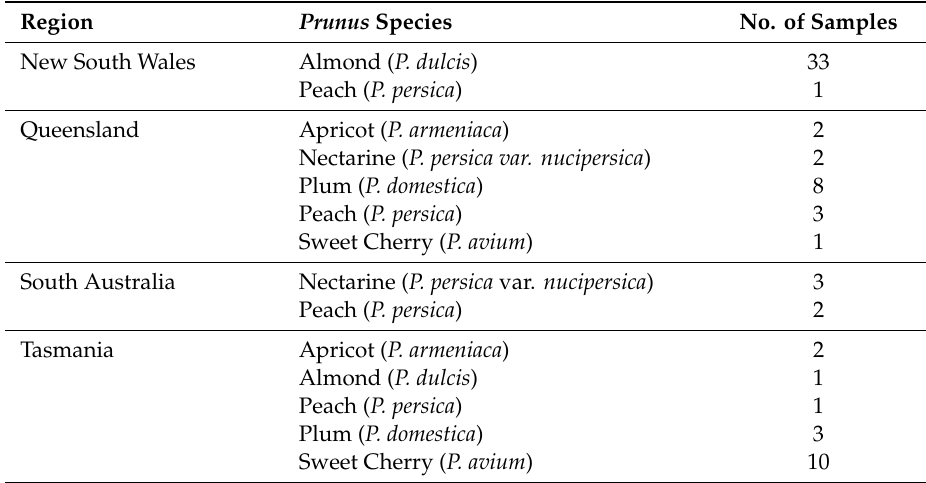
Table 1. The region within Australia in which samples were collected and the number of samples of each Prunus species that were tested for three viroids and 34 viruses. Region Prunus Species No. of Samples New South Wales Almond ( P. dulcis ) 33 Peach ( P. persica ) 1 Queensland Apricot ( P. armeniaca ) 2 Nectarine ( P. persica var. nucipersica ) 2 Plum ( P. domestica ) 8 Peach ( P. persica ) 3 Sweet Cherry ( P. avium ) 1 South Australia Nectarine ( P. persica var. nucipersica ) 3 Peach ( P. persica ) 2 Tasmania Apricot ( P. armeniaca ) 2 Almond ( P. dulcis ) 1 Peach ( P. persica ) 1 Plum ( P. domestica ) 3 Sweet Cherry ( P. avium )